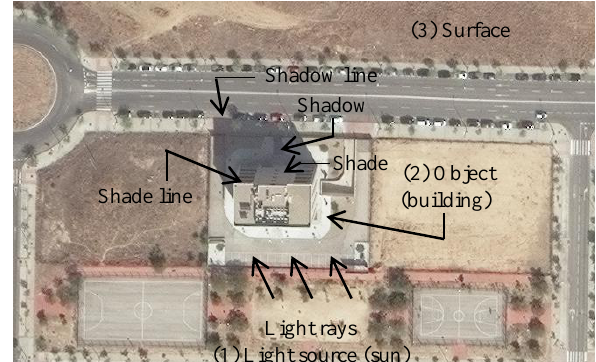
Figure 1. Shadow conditions using real satellite image.